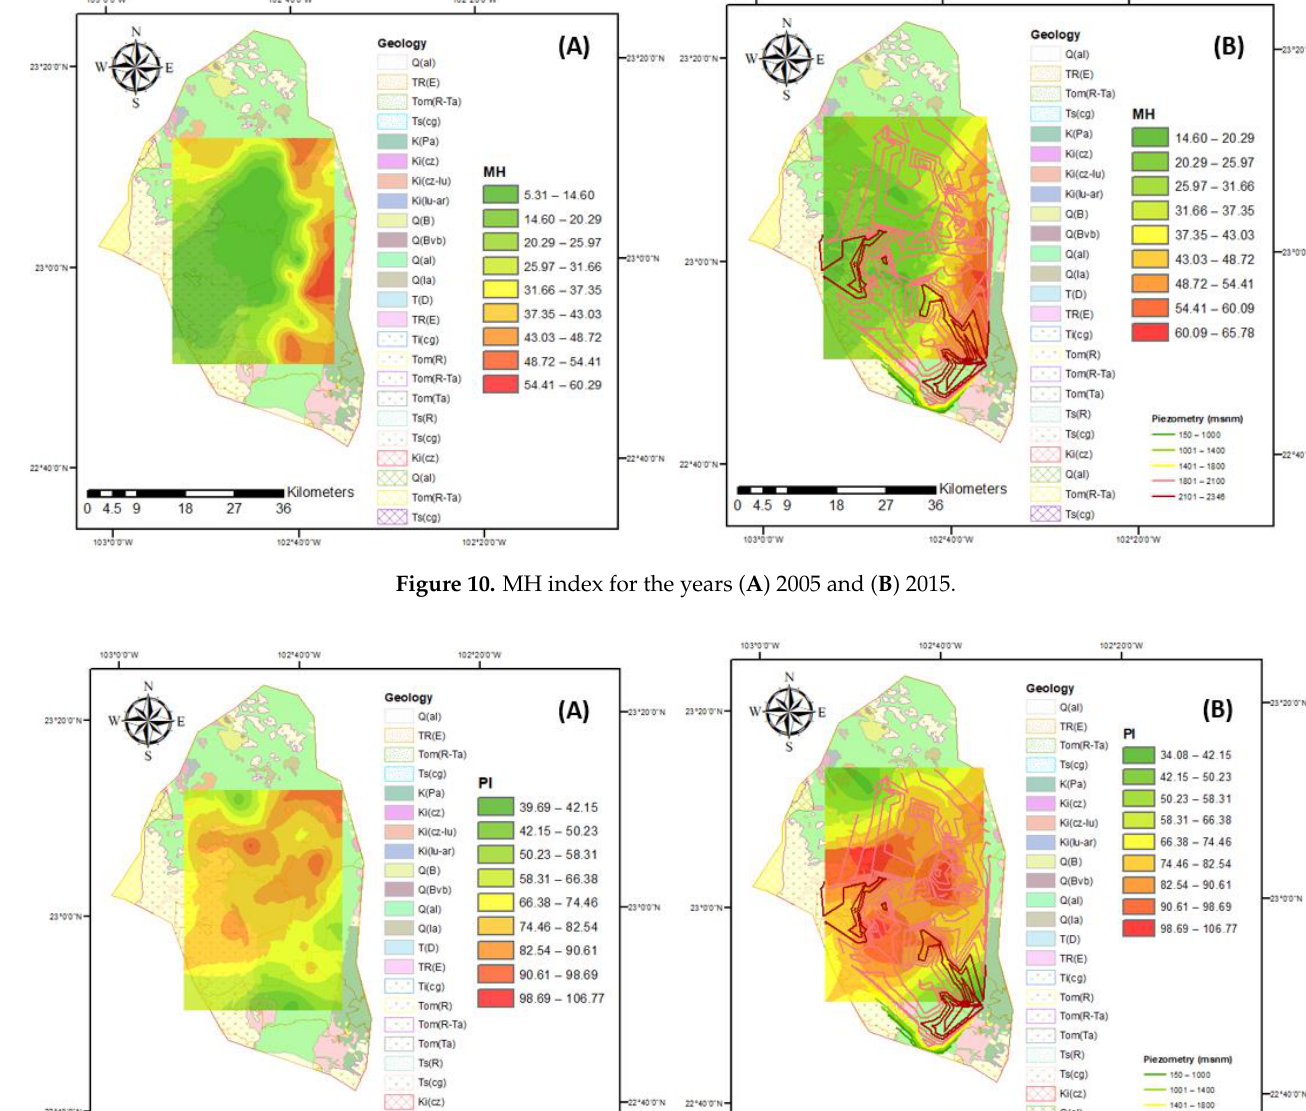
Figure 10. MH index for the years ( A ) 2005 and ( B ) 2015.